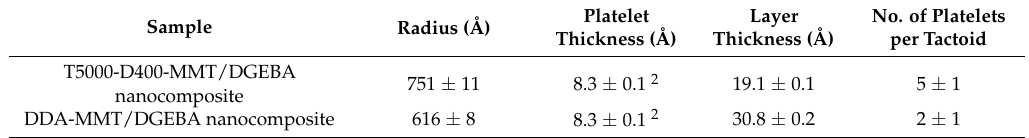
Figure 7. ( a ) SANS intensity profiles and fitted lines nanocomposites reinforced by DDA-MMT and T5000-D400-MMT at 3 wt% clay loading according to a sandwich structure model and ( b ) the separate form and structure factors. Table 4. Fitting results obtained from SANS for nanocomposites reinforced by DDA-MMT